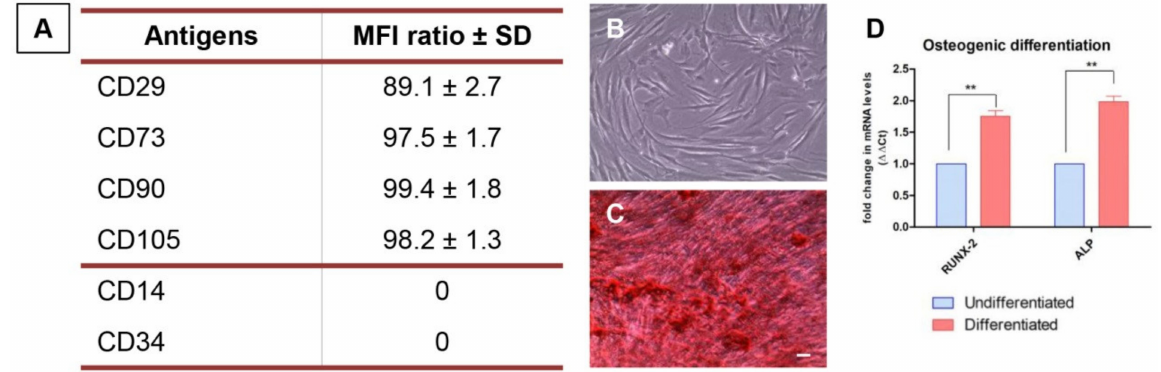
Figure 1. hPDLSCs characterization. ( A ) Flow cytometry results of the expression of surface markers. ( B ) Representative light microscopy image of plastic-adherent hPDLSCs cultured in standard conditions. ( C ) Cells were positive for Alizarin red S staining after 3 weeks of differentiation. ( D ) RT-PCR showed the upregulation of osteogenic related in differentiated hPDLSCs. Scale bar: 10 µ m. ** p <